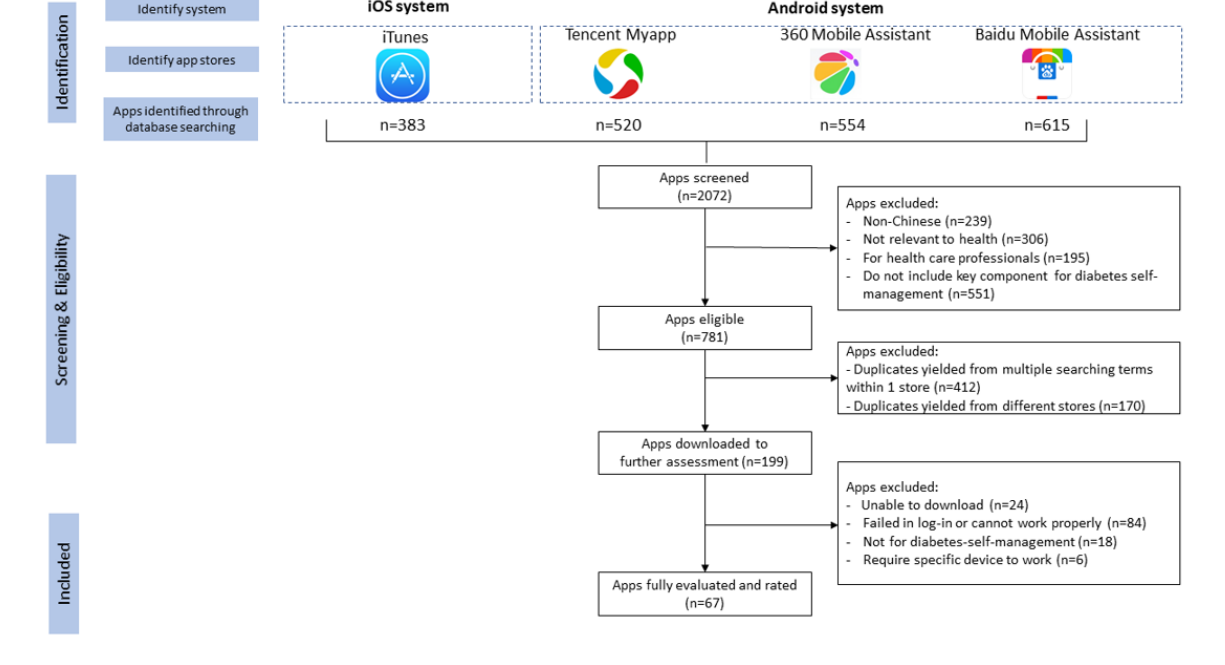
Figure 1. Screening process based on the Preferred Reporting Items for Systematic Reviews and Meta-Analyses